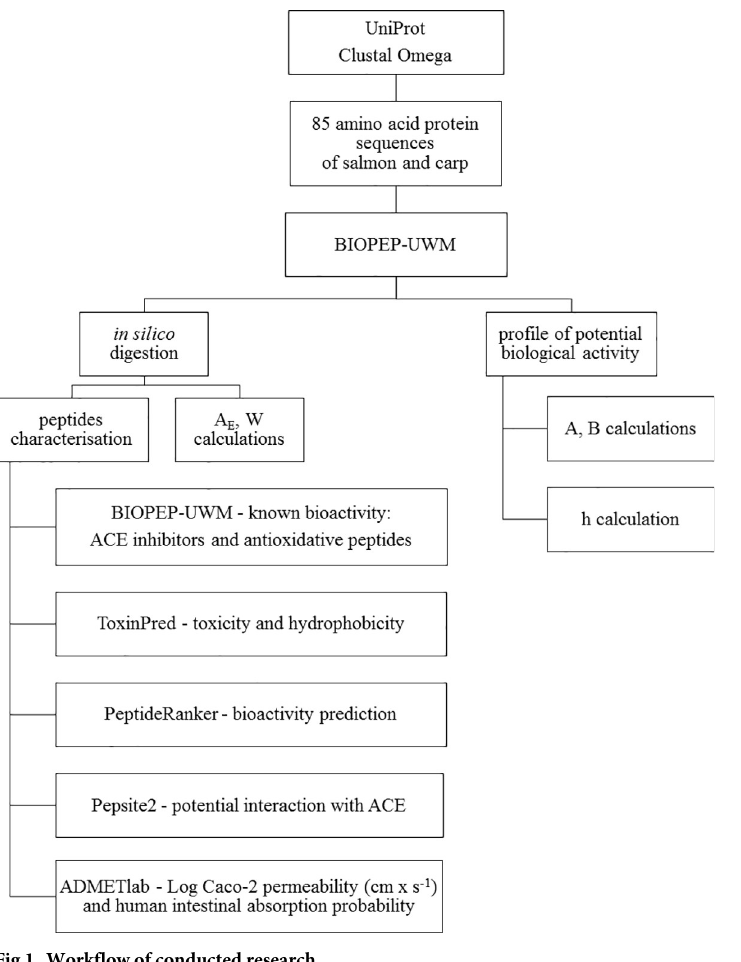
Fig 1. Workflow of conducted